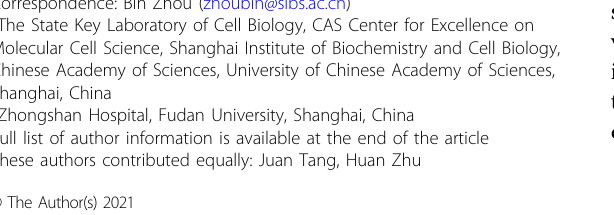
Fig. 1m). Flow cytometric analysis of left ventricle con- fi rmed that the percentage of GFP + ECs in TAC was signi fi cantly higher than sham group (Sham 30.05 ±